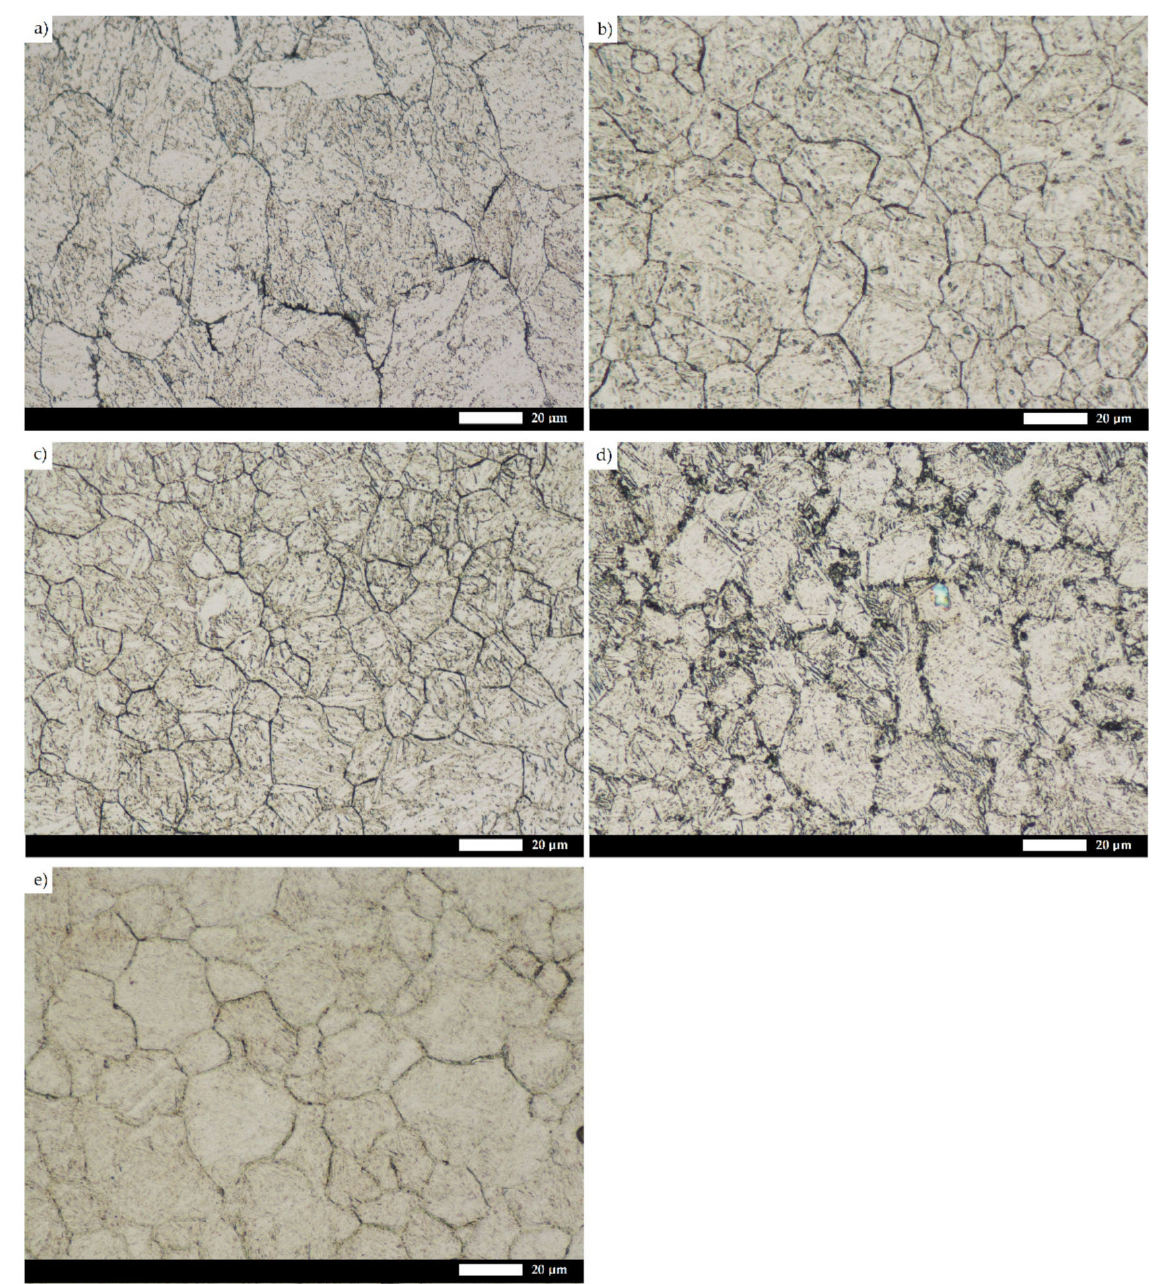
Figure 6. Microstructure of the tested types of steels with visible prior austenite grain boundaries: ( a ) Creusabro 4800; ( b ) Creusabro 8000; ( c ) TBL PLUS; ( d ) XAR 600; ( e ) 38GSA. Light microscopy, 500 × , etched with